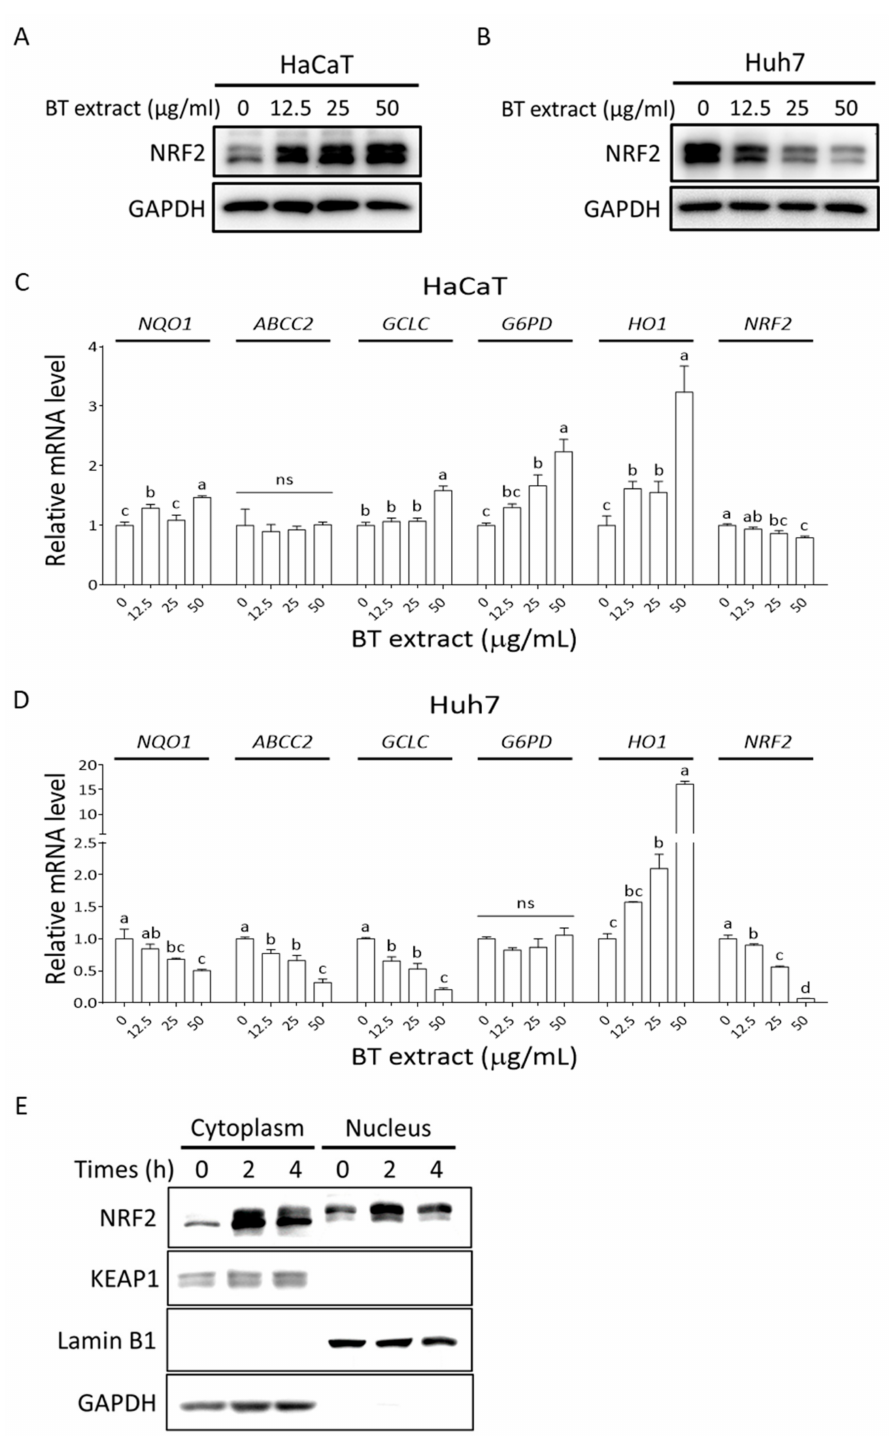
Figure 4. The effect of BT extract on NRF2 signaling in Huh7 and HaCaT cells. ( A , B ) HaCaT and Huh7 cells were treated with indicated concentrations of BT extracts for 8 h. NRF2 protein level was measured by immunoblot. ( C , D ) The HaCaT and Huh7 cells were treated with indicated concentrations of BT extracts for 18 h. Total RNA was isolated and submitted to reverse transcription and QPCR for the detection of NRF2 and expression levels of its target genes. Statistical analysis was performed using ANOVA, and different superscript letters indicate statistically significant differences ( p < 0.05); ns, nonsignificant. ( E ) HaCaT cells were exposed to 50 µ g/mL BT extract for 2 and 4 h. The levels of NRF2 and KEAP1 in cytoplasm and nuclei were detected by immunoblot. Lamin B1 and GAPDH served as nuclear and cytoplasmic markers,